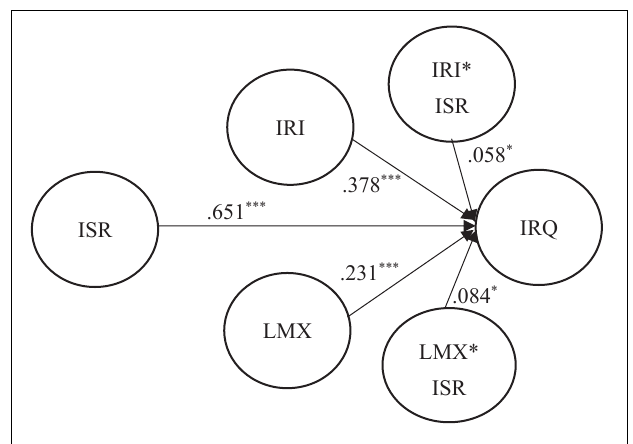
FIGURE 2 | Structural model on Taiwanese employees. ∗ p < 0.05 and ∗∗∗ p < 0.001.